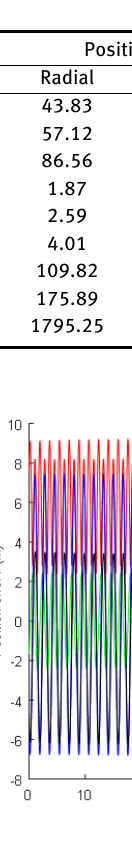
Table 4. Orbital errors in 1-day, 3-days, and 7-days predictions of three type orbits